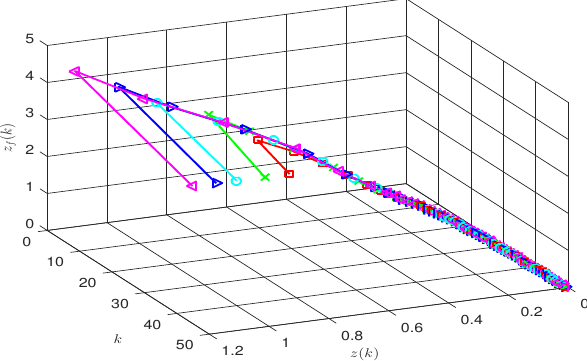
Figure 7. The simulations of z ( k ) and z f ( k ) under different initial